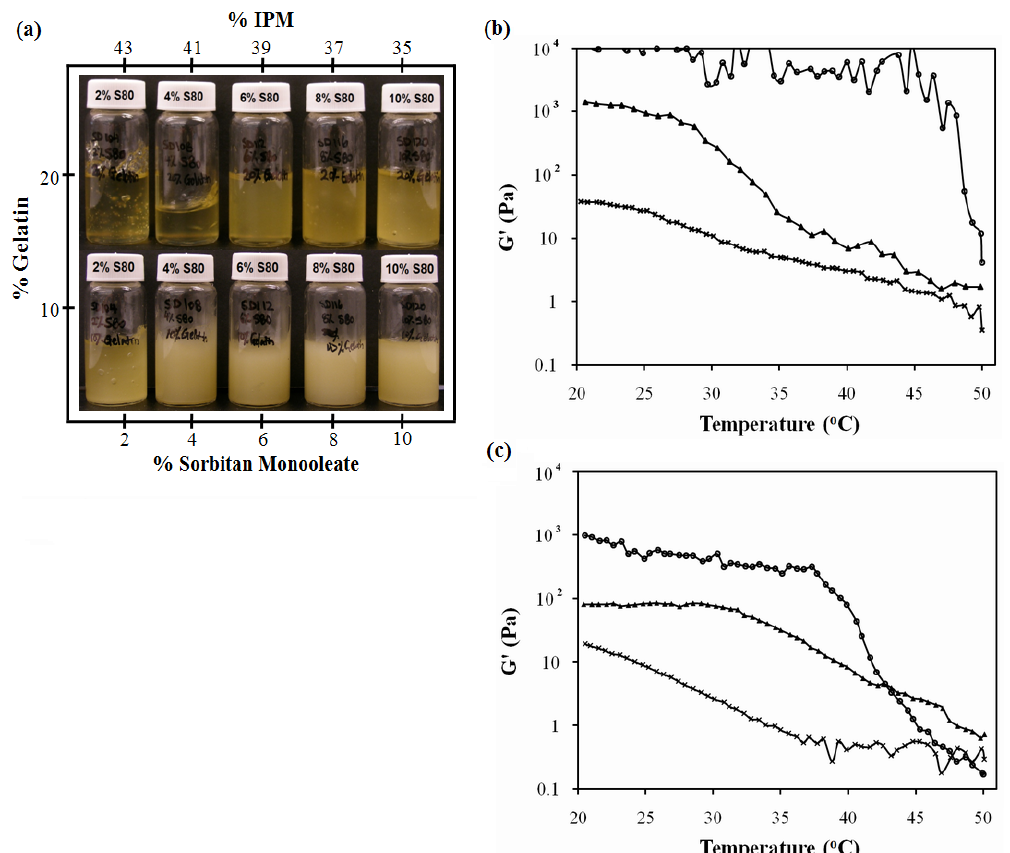
Figure 3. SMO scan of lecithin-linker MBGs. All formulations contain 10% PEG-6-caprylic/capric glycerides, 4% decaglycerol monocaprylate/caprate, 5% lecithin, 36% of 0.9% NaCl solution and the balance of isopropyl myristate (IPM). ( a ) Gel appearance. Elastic modulus (G’) vs. temperature profile of ( b ) 20% gelatin MBGs and ( c ) 10% gelatin MBGs containing (×) 2% SMO; ( ▲ ) 10% SMO; Control (10% or 20% gelatin in 0.9% NaCl solution) ( ● ) Table 1 present additional μ E composition details. For the systems of panel ( b ), a linear regression between log(G’) and T (from 25 to 40 °C) was evaluated for gelatin, log(G’,Pa) = 4.7(±0.3) − 0.027(±0.009)T(°C), (R 2 = 0.27); for 10% SMO-gelatin log(G’,Pa) = 7.3(±0.2) − 0.163 (±0.009)T(°C), (R 2 = 0.98); for 2% SMO-gelatin log(G’,Pa) = 2.93(±0.06) − 0.062 (±0.002)T(°C), (R 2 = 0.97). The ±deviations in parentheses represent the standard deviation of the regression